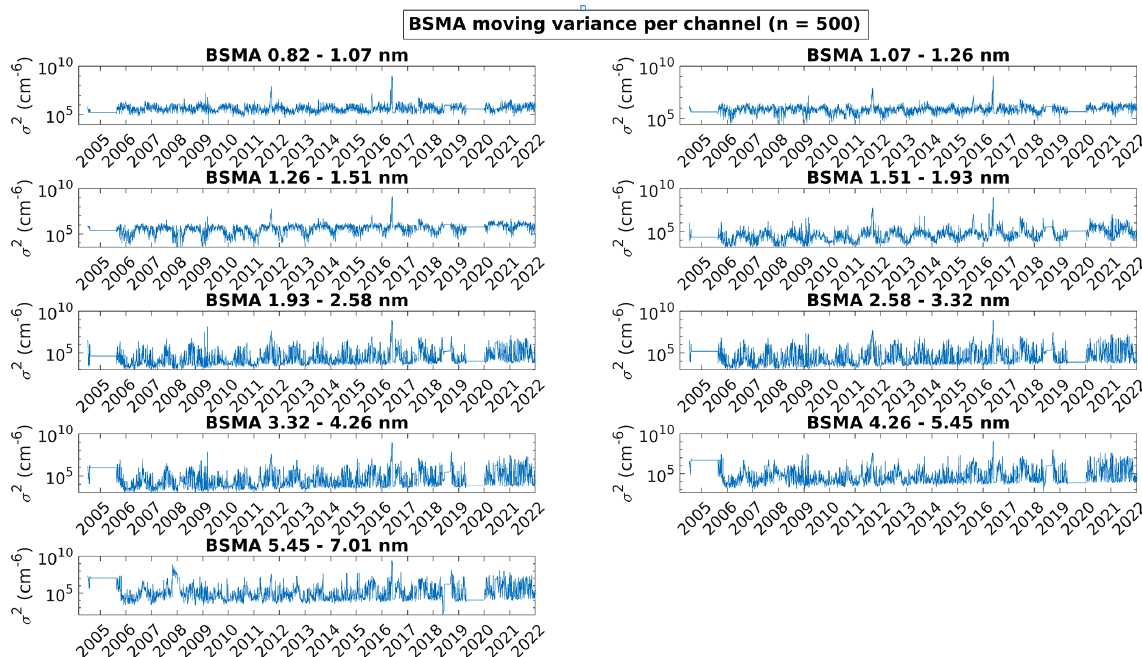
Figure A1. Moving variance of the concentration time series of the BSMA size channels. The symbol n indicates the number of closest data points used for the calculation of the variance at each point. The time resolution is the time resolution of the instrument, which is 12min.